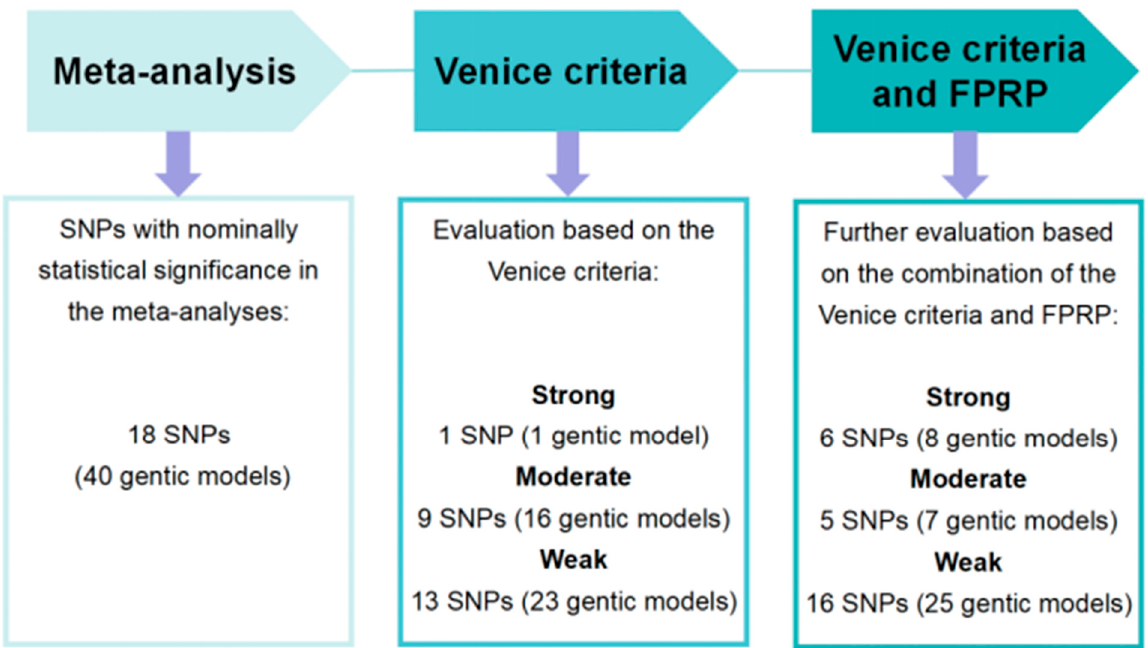
Figure 3. The process of the assessment for cumulative evidence.